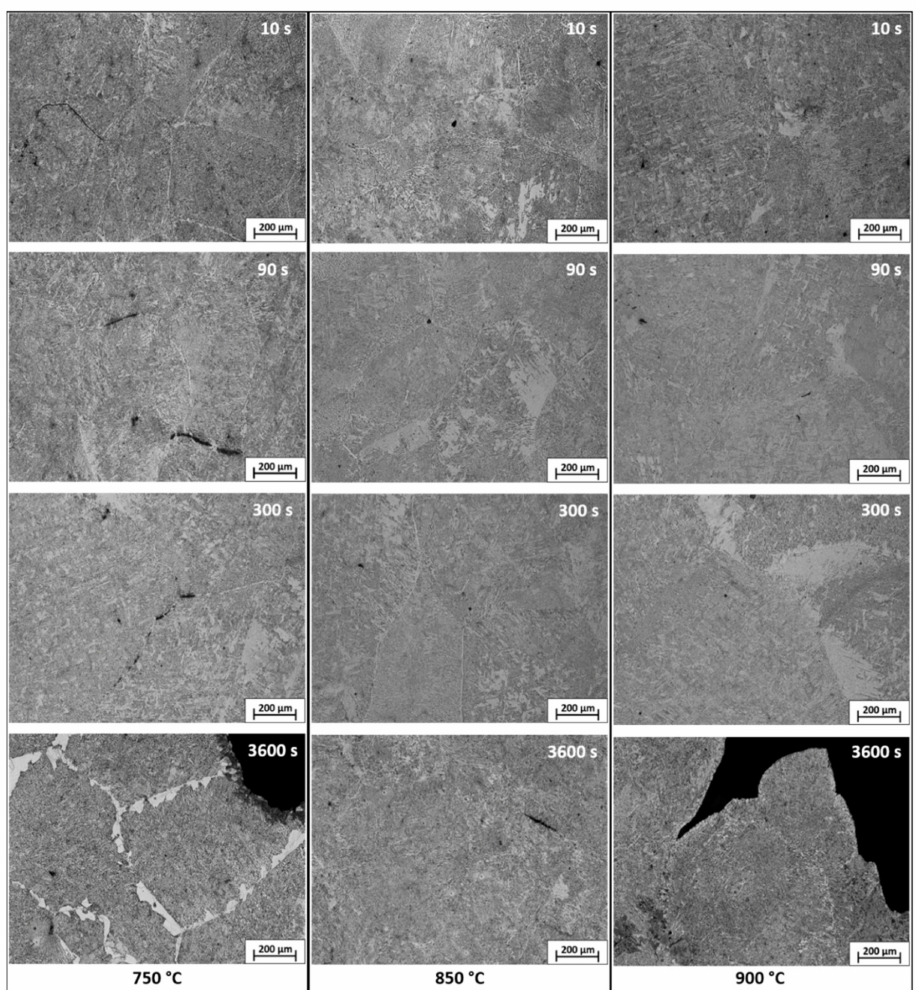
Figure 10. LOM images with 100 × magnification of samples etched with 3% Nital, tested at 750, 850, and 900 ◦ C and with 10, 90, and 300 s of holding